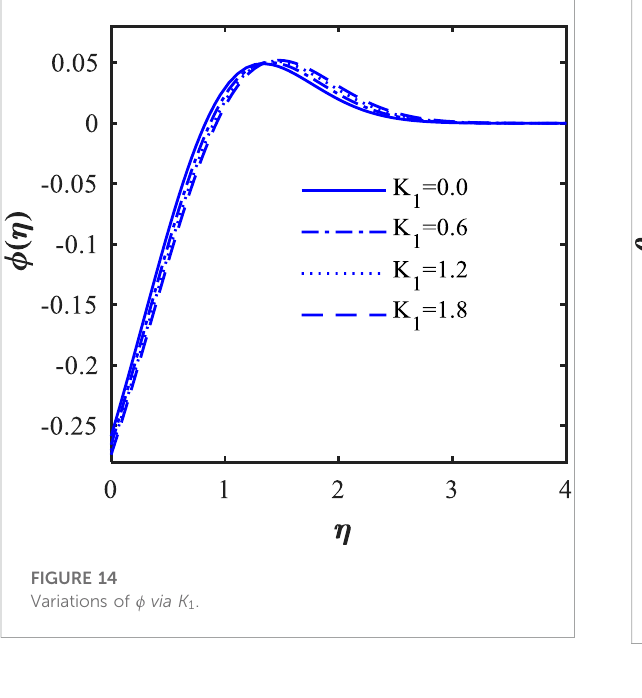
FIGURE 16 Variations of θ via Q .